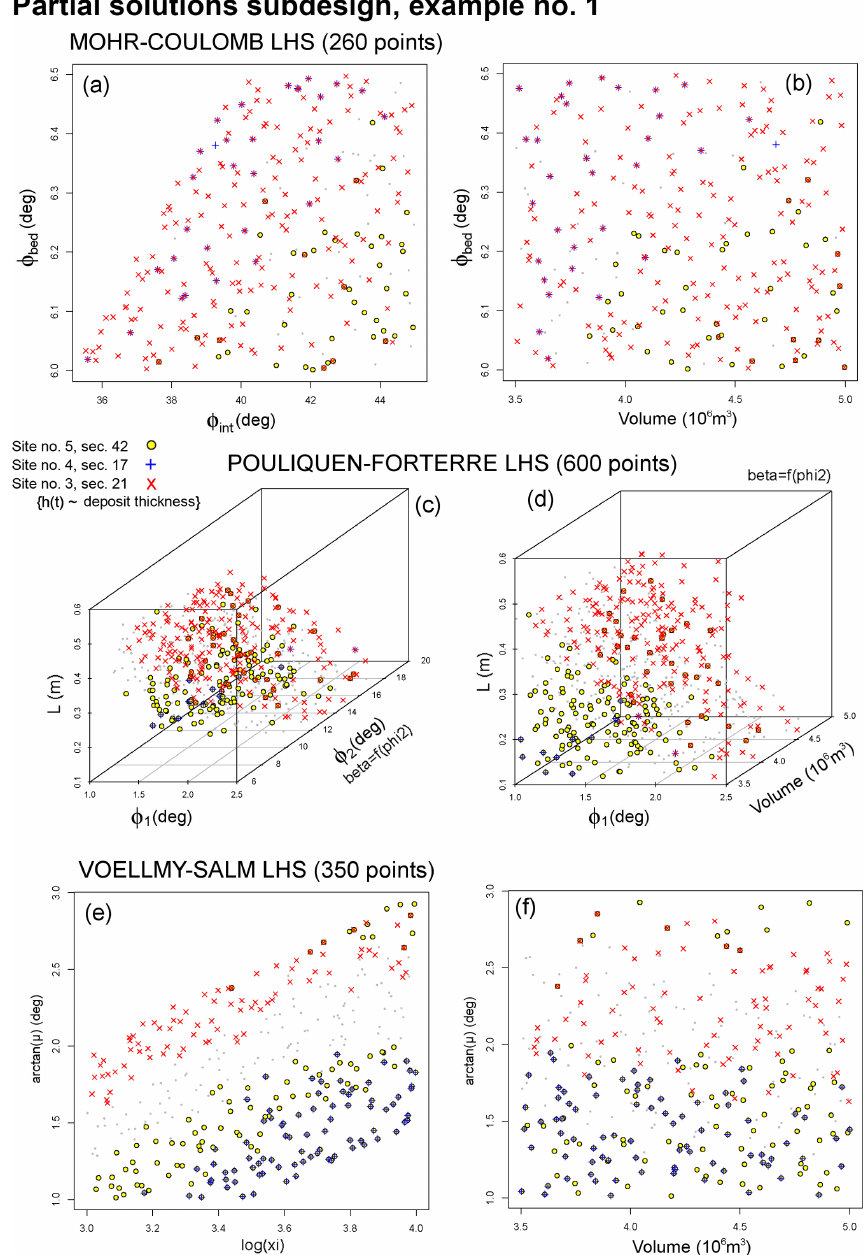
Figure 14. Example 1 of partial solution inputs in (a, b) MC, (c, d) PF, and (e, f) VS experimental design. Panels (a, c, e) are projected along the V coordinate, and (b, d, f) are projected along φ int , φ 2 and ξ coordinates. The color expresses the considered data: yellow is deposit thickness at Site 5, blue at Site 4, and red at Site 3 (Saucedo et al.,